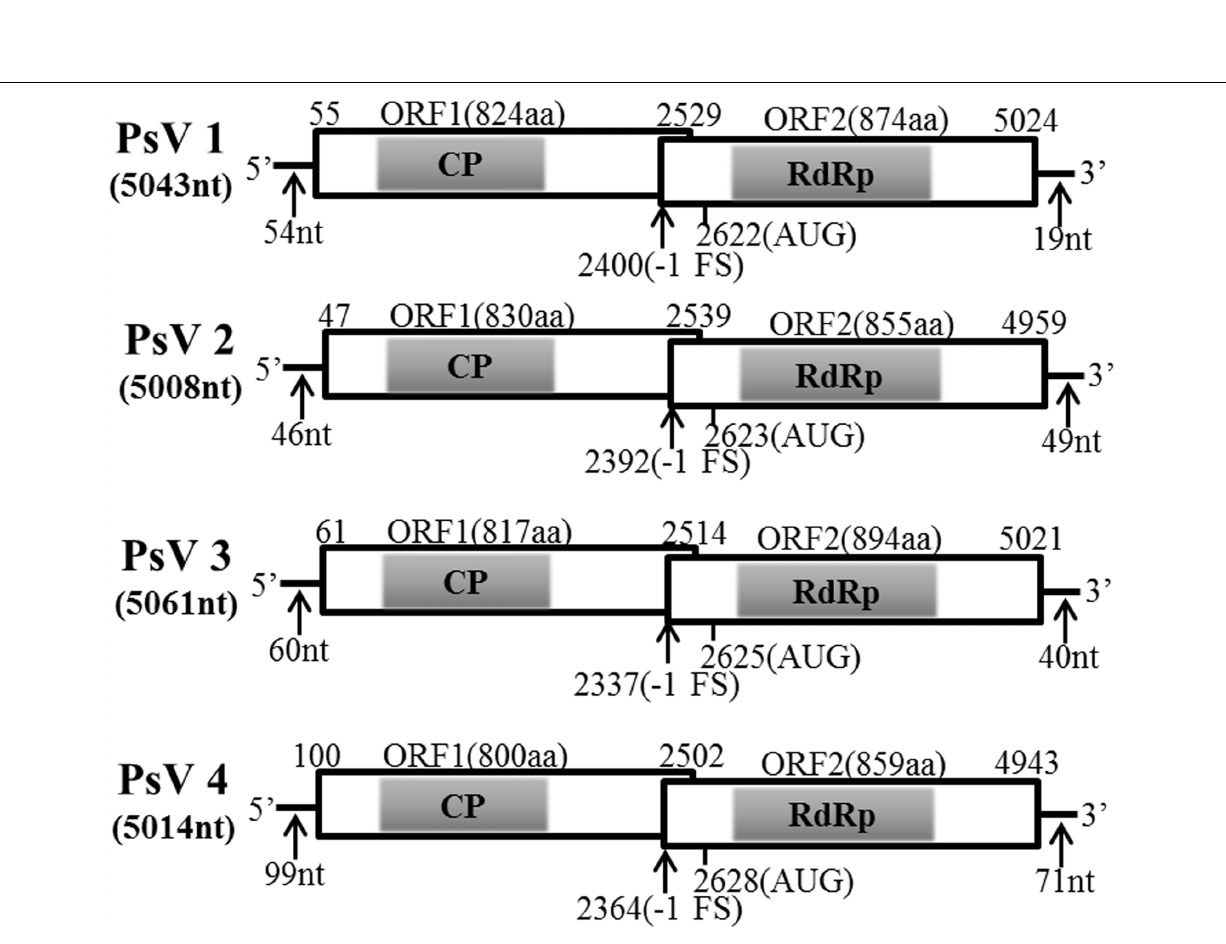
FIGURE 1 | Puccinia striiformis f. sp. tritici urediniospores contain dsRNA-like nucleic acids elements. (A) Symptoms of stripe rust disease on wheat leaves. (B) P. striiformis urediniospores collected from wheat leaves. (C) Agarose gel electrophoresis of dsRNA extracted from the urediniospores of P. striiformis . M indicates molecular markers of λ DNA digested with Hind III.